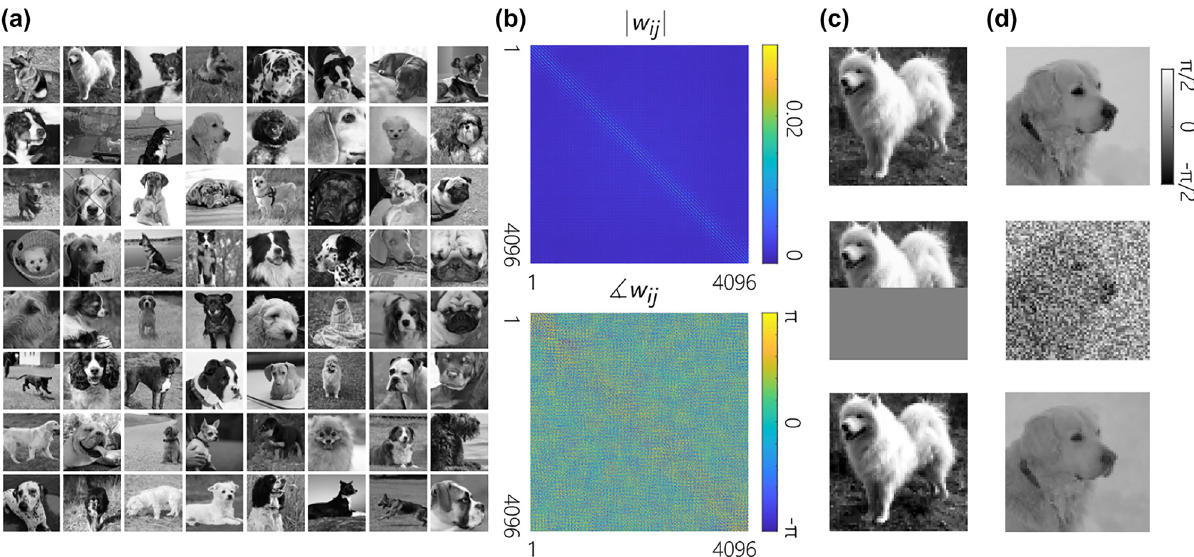
Figure 4: Reconstruction of gray-scale images by CLNs with proper weight matrices. (a) A set of k = 64 grayscale images of n = 64 × 64 pixels used for training the weight matrix of the CLN. (b) The amplitude and phase of the trained complex weight matrix. (c, d) reconstruction of the corrupted versions of two images from the training dataset.